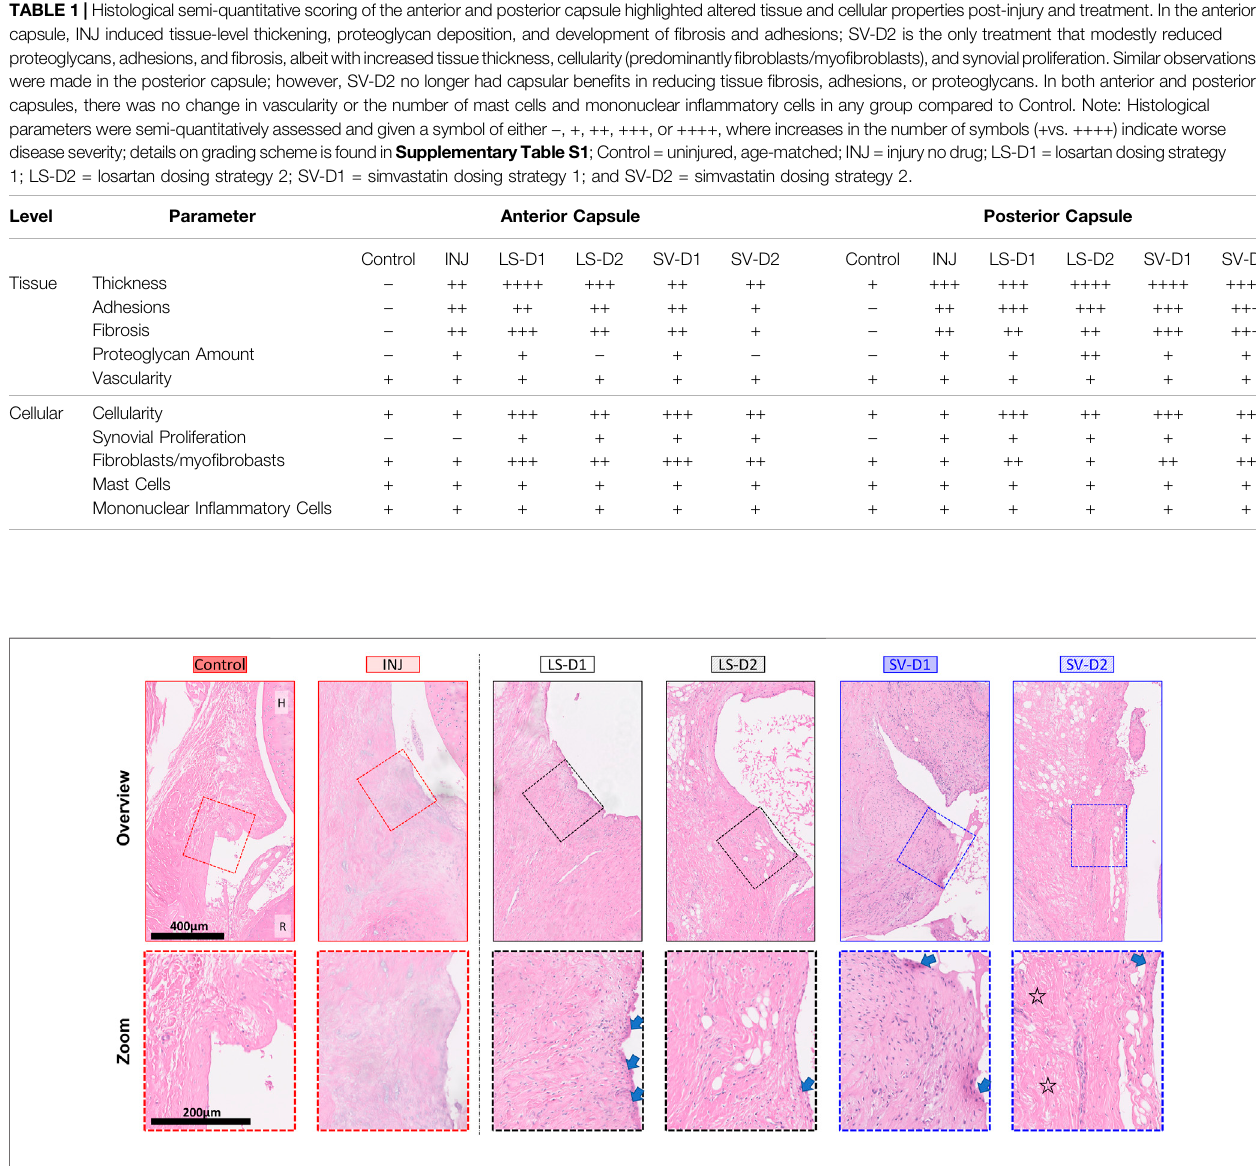
FIGURE 4 | SV, but not LS, modestly reduced capsule fi brosis anteriorly, albeit with increased tissue thickness and cellularity . Qualitative histopathology assessmentonH&Emidsagittalsectionsoftheanteriorcapsulehighlightschangesintheoverallcapsuletissueandcellularmorphology.Controlcapsuledisplaysloosely packed and disorganized tissue with minimal cellularity, whereas injury caused thickened tissue and fi brosis with minimal cells. Treatments displayed increased thickness, cellularity (mostly fi broblasts/myo fi broblasts), synovial proliferation (arrows), and fi brosis. However, SV-D2 was the only group able to modestly reduce capsule fi brosis(openstar).Note:H (cid:1) humerus;R (cid:1) radius;Control (cid:1) uninjured,age-matched;INJ (cid:1) injurynodrug;LS-D1 (cid:1) losartandosingstrategy1;LS-D2 (cid:1)